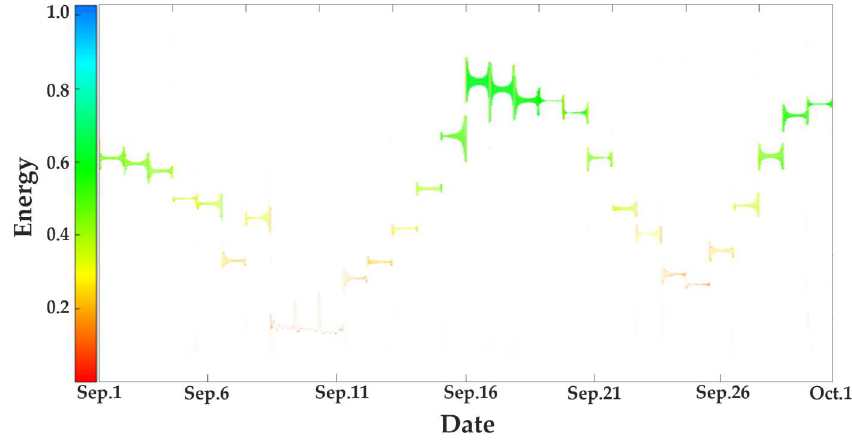
Figure 9. Hilbert spectrum of the monthly generation waveform of tidal power.